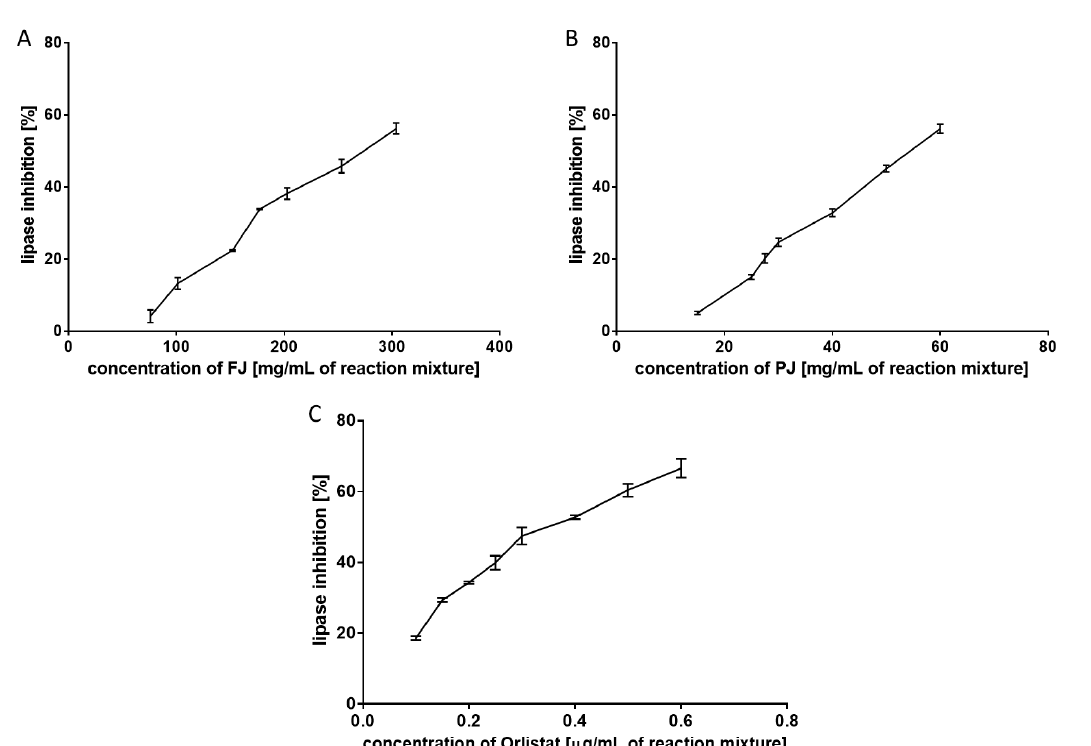
Figure 2. Inhibitory e ff ect of fresh juice (FJ) ( A ), purified juice (PJ) ( B ), and Orlistat ( C ) on pancreatic lipase. Data are means of triplicate assays ± standard deviations.